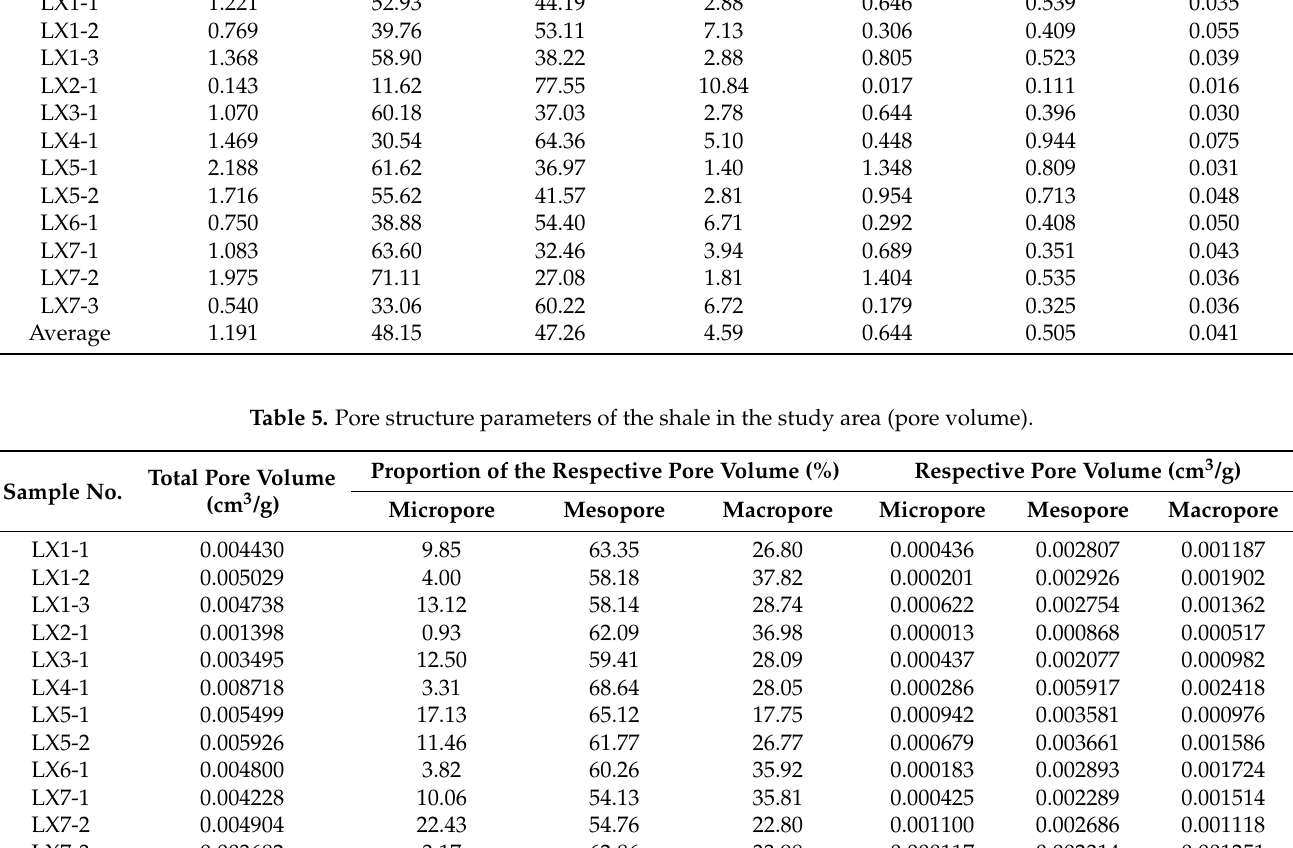
Table 4. Pore structure parameters of the shale in the study area (surface area). Sample No.